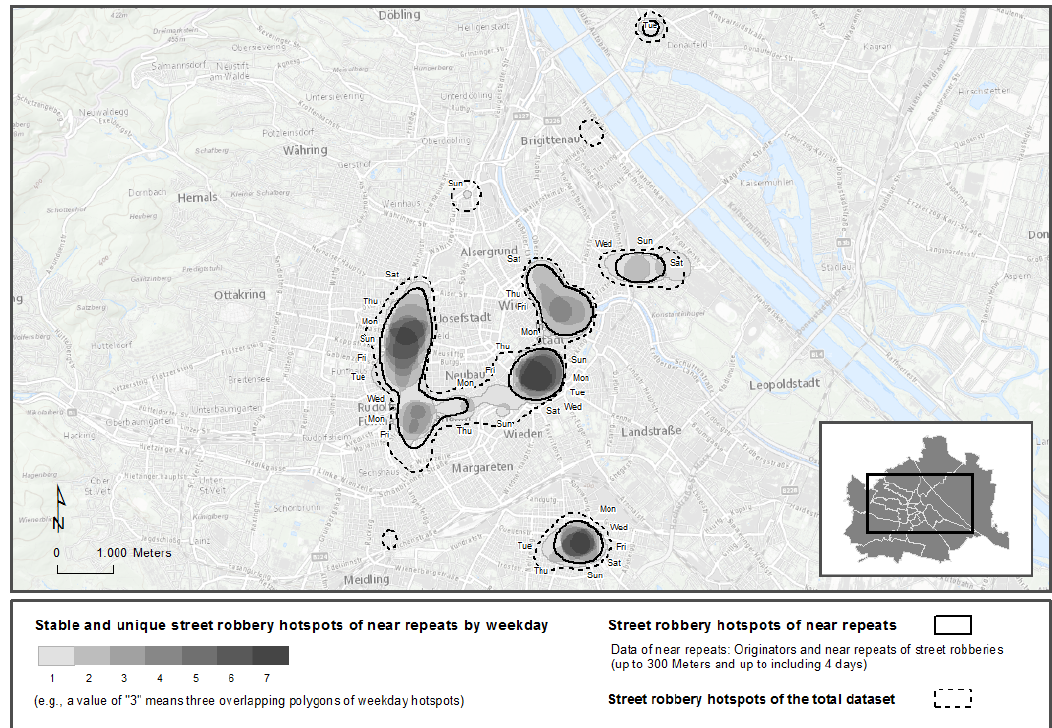
Figure 2. Street robbery hotspots of near-repeats by weekday.